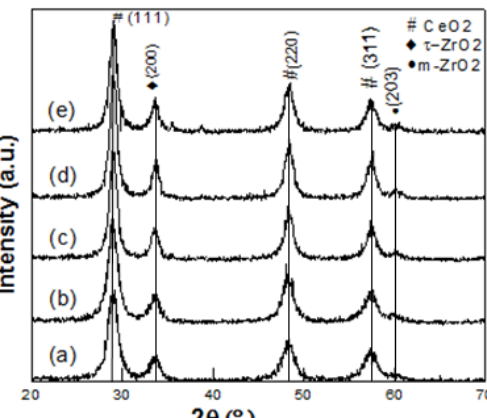
Fig.2. XRD patterns of the CuO/CeO